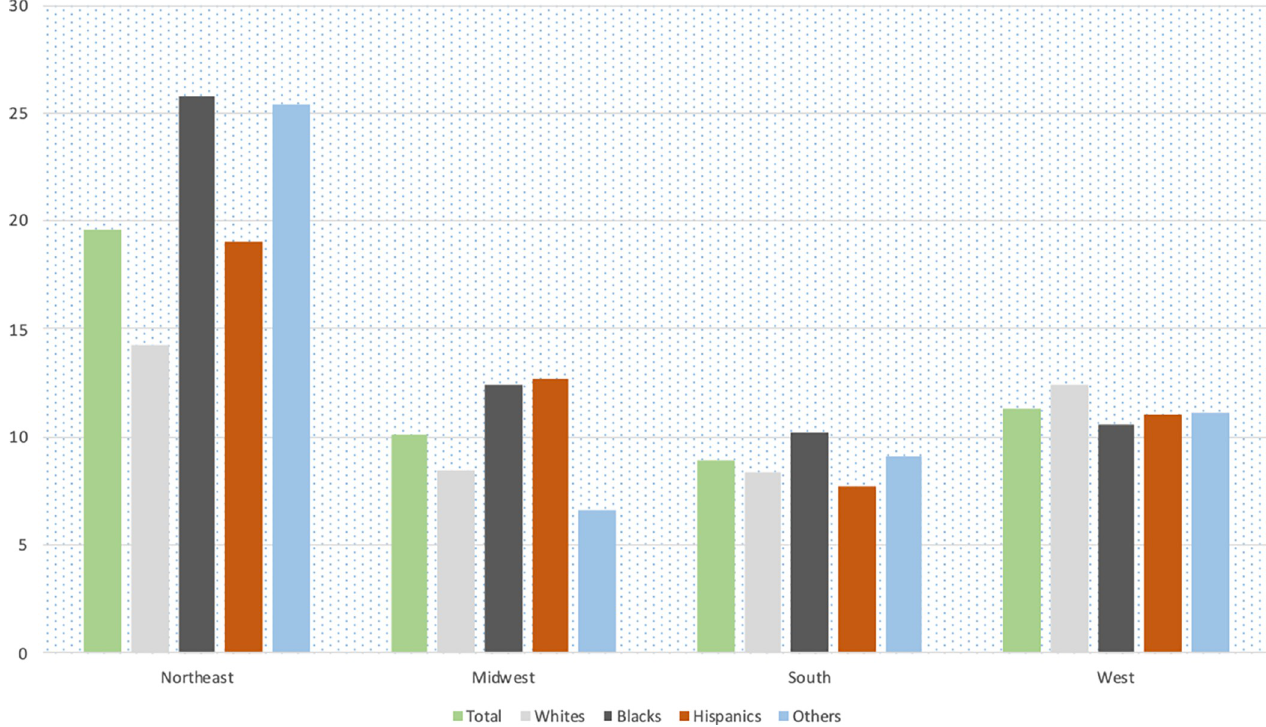
Fig 1. Unadjusted mortality rates (%) per 100 hospitalized COVID-19 patients by racial group among patients < 60 years.